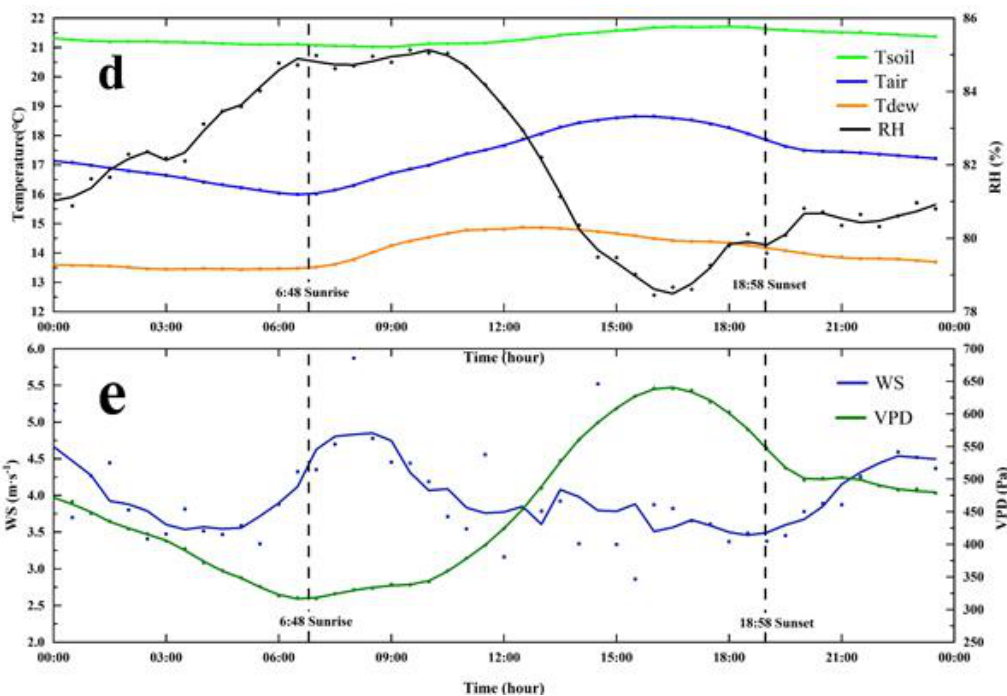
Figure 9. Characteristics of environmental factors. ( a – c ) Annual daily scale characteristics of environmental factors. ( d , e ) Half − hour scale characteristics of environmental factors at the same time throughout the year. Tair represents air temperature, Tdew represents dew point temperature, Tsoil represents soil temperature, RH represents relative humidity, WS represents wind speed, VPD represents vapor pressure deficit.